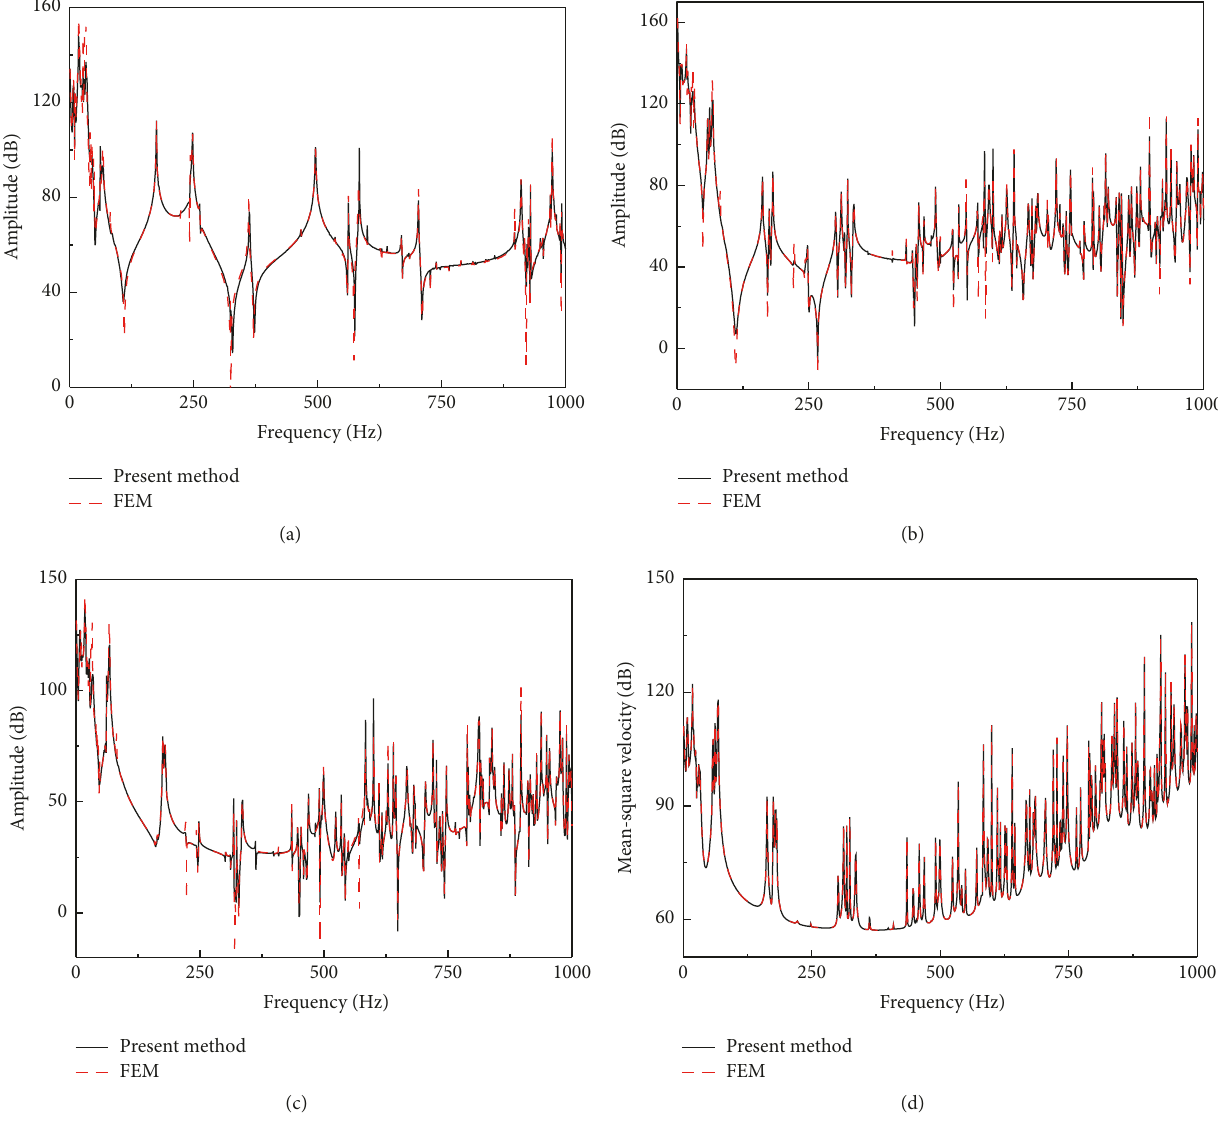
Figure 5: Comparison of the synthesized FRFs and the simulated results excited by multisourced multidirection forces: (a) displacement of the lower isolator in 𝑧 -direction; (b) displacement of the lower isolator in 𝑥 -direction; (c) displacement of point between hull and attached pipes in 𝑧 -direction; (d) mean-square velocity of hull